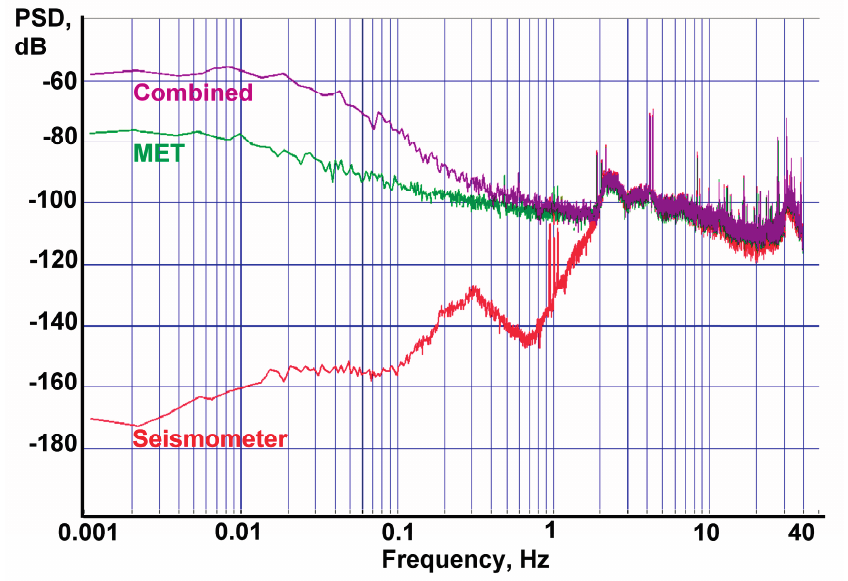
Figure 15. Final PSD. Purple is the combined sensor, green is the MET only sensor with the correction filter, red is the reference seismometer CME-6211. 0 dB = 1